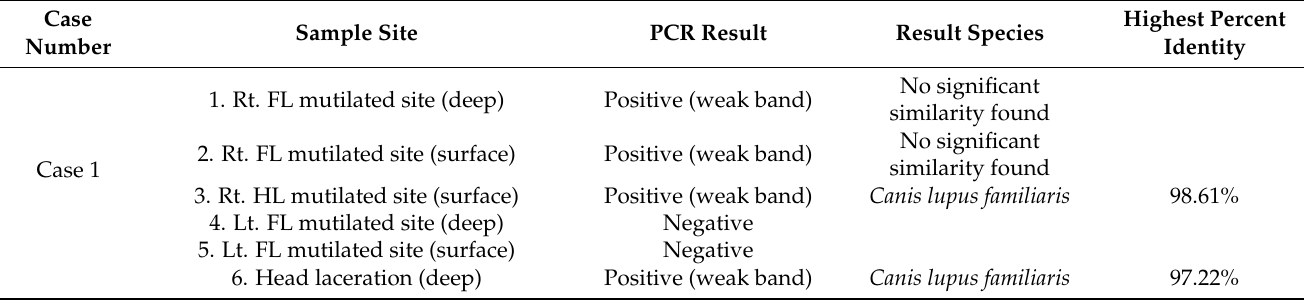
Table 3. PCR and BLAST results of wound swabs.